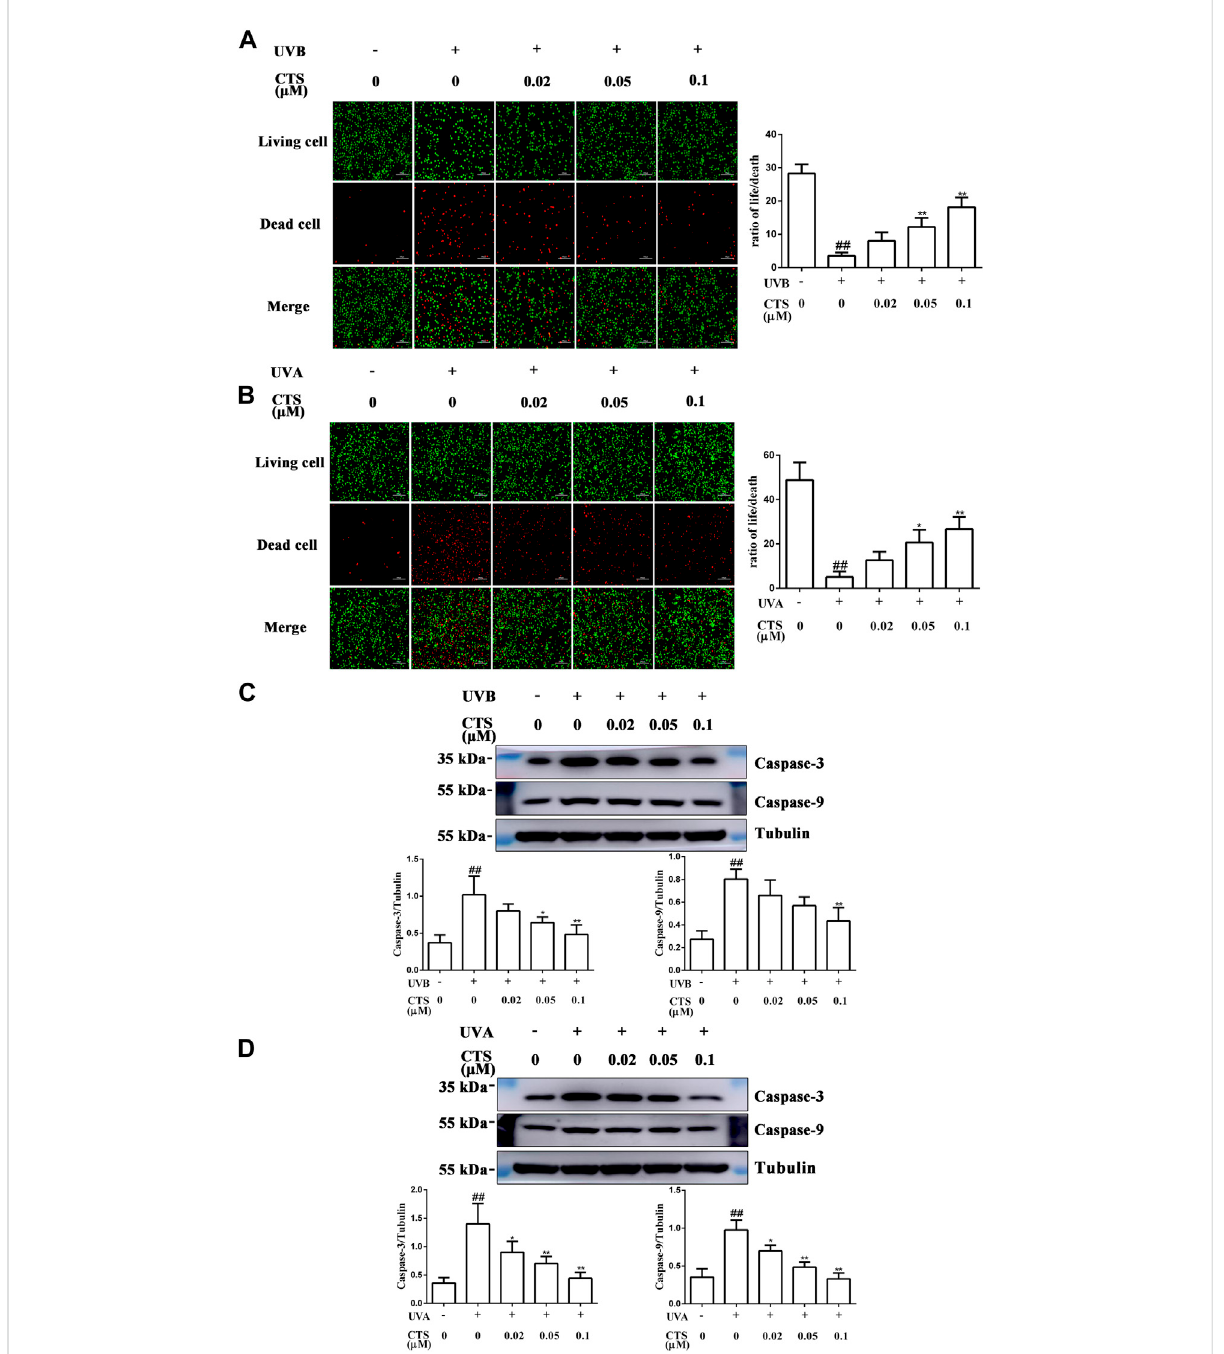
FIGURE 4 Effects of CTS on UV radiation-induced apoptosis in HaCaT cells and HFF-1 cells. HaCaT cells and HFF-1 cells were treated without and with CTS (0.02, 0.05, 0.1 μ M) for 4 h prior to UVB (200 mJ/cm 2 ) and UVA (15 J/cm 2 ) irradiation, respectively. After UV irradiation, the cells were supplemented with the corresponding concentrations of CTS and incubated for different times before analysis. Calcein-AM/PI double staining of HaCaT cells after incubating for 6 h following UVB irradiation (A) and HFF-1 cells after incubating for 24 h following UVA irradiation (B) . Red fl uorescencerepresentsthedeadcells,whereasgreen fl uorescencerepresentsthelivecells.Scalebars:100 μ m.Theplotsshowtheratiooflivingto deadcells.Caspase-3andcaspase-9levelsinHaCaTcells (C) andHFF-1cells (D) afterincubating0.5 hfollowingUVirradiationasassayedbywestern blot. The plots show the quantitative analysis of protein expression. All data are mean ± SD from three independent experiments, “ ## ” indicates signi fi cantlydifferentfromthecontrol(noirradiationandCTStreatment)atthe p < 0.01level,whereas “ * ” and “ ** ” indicatesigni fi cantlydifferentfrom the UV-irradiated cells without CTS pretreatment at the p < 0.05 and p < 0.01 levels,